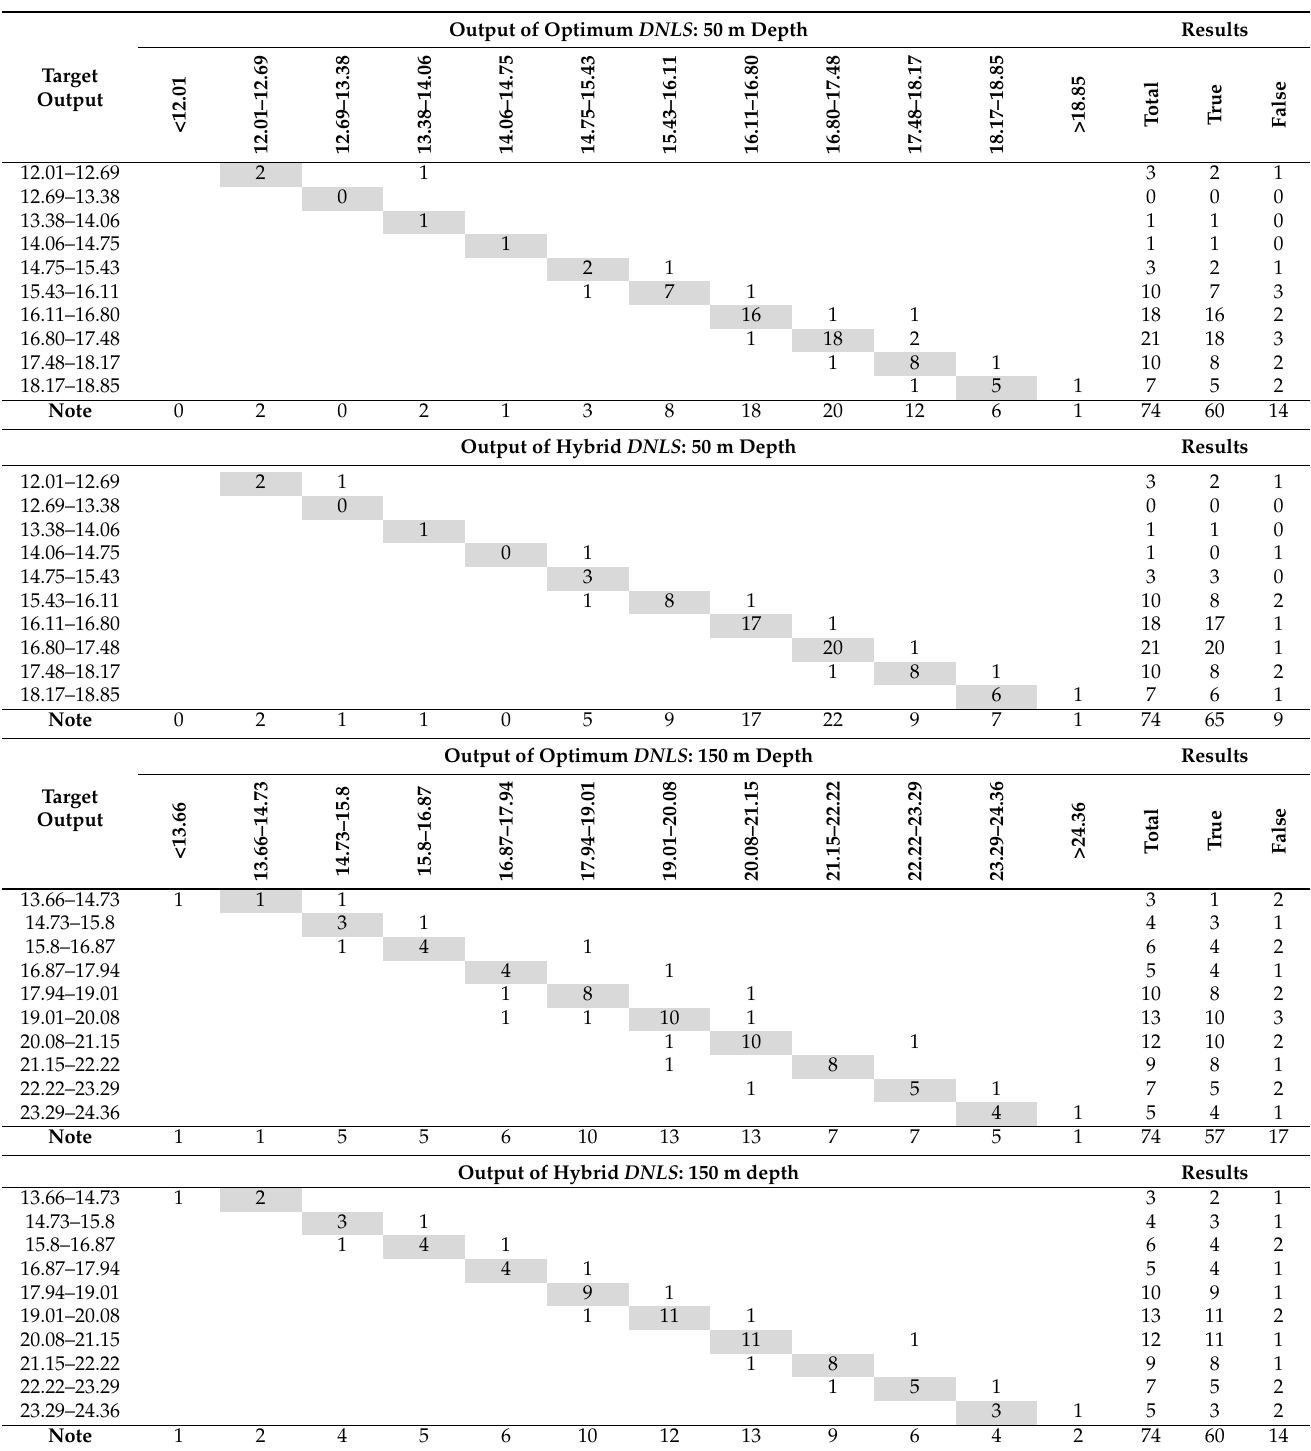
Table 3. Confusion matrix of optimum models using validation